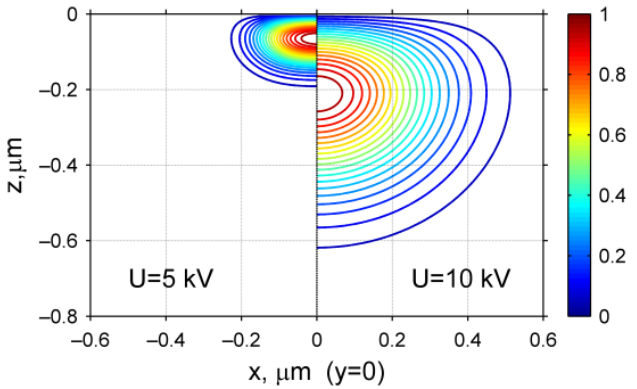
Figure 2. Calculated distributions of injected charges for Scheme A at H = 0.25 μm and accelerating voltages of 5 kV and 10 kV. The distributions are normalized to their maximum values. The isolines are drawn in increments of 0.05.